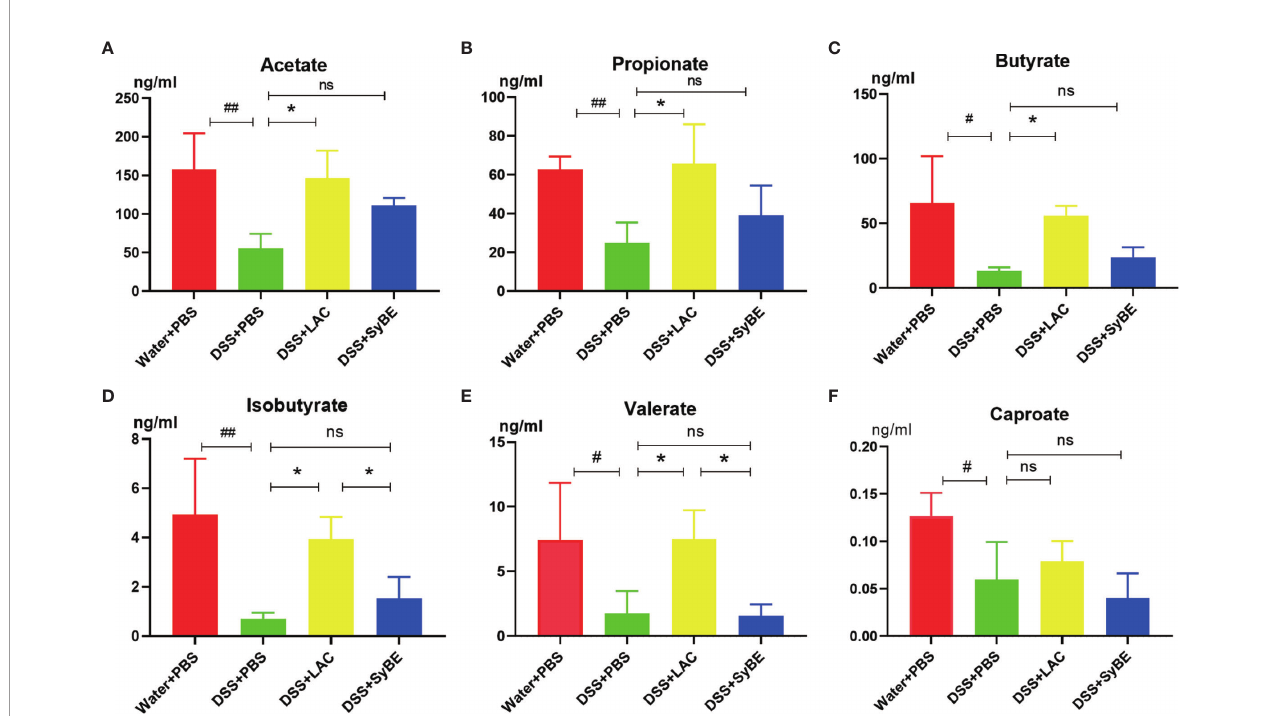
FIGURE 8 | Short-chain fatty acids in colitis mice signi fi cantly showed lower levels of acetate (A) , propionate (B) , butyrate (C) , isobutyrate (D) , valerate (E) , and caproate (F) . # p < 0.05; ## p < 0.01 vs. the Water+PBS group; * p < 0.05 vs. the DSS+PBS group ( n = 6). ns, no signi fi cance.